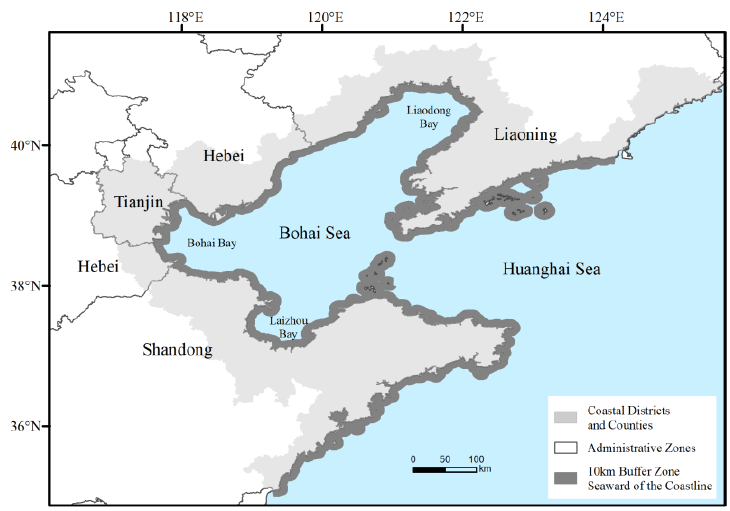
Figure 1. Overview map of the study